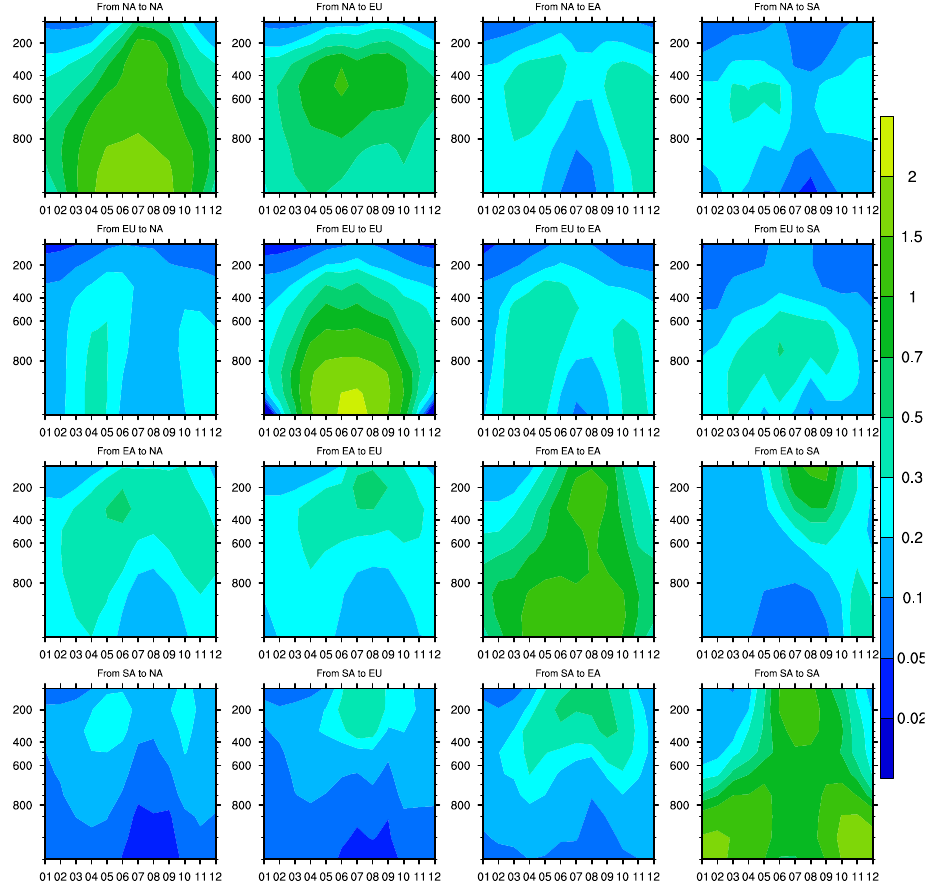
Fig. 2: Effects of emission reductions (2001) as a function of height (hPa) from North America (NA), Europe (EU), East Asia (EA) and South Asia (SA) on ozone (ppb) as a function of month number. The top row shows the effects averaged over the NA domain, the second row shows the effects over the EU domain, the third row shows the effects over the SA domain and the last row shows the effects over the SA domain. averaged over one year calculated with the model ensemble of the first 7 models listed in Table 1.